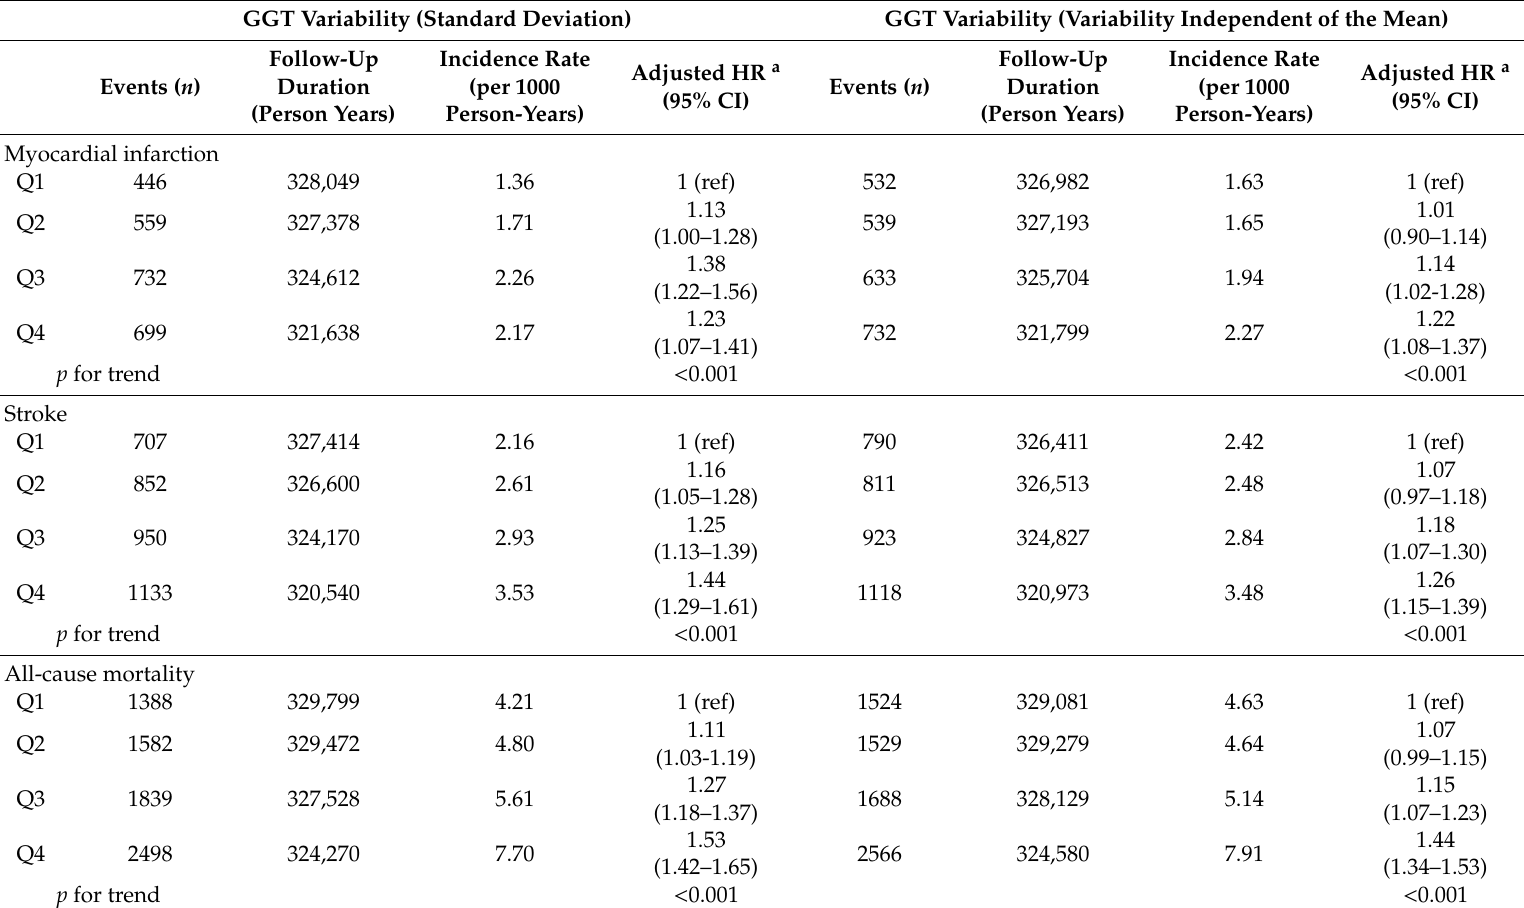
Table 3. Hazard ratios and 95% confidence intervals of myocardial infarction, stroke, all-cause mortality, and cardiovascular disease-related mortality by quartiles of γ -glutamyltransferase (GGT) variability (standard deviation and variability independent of the